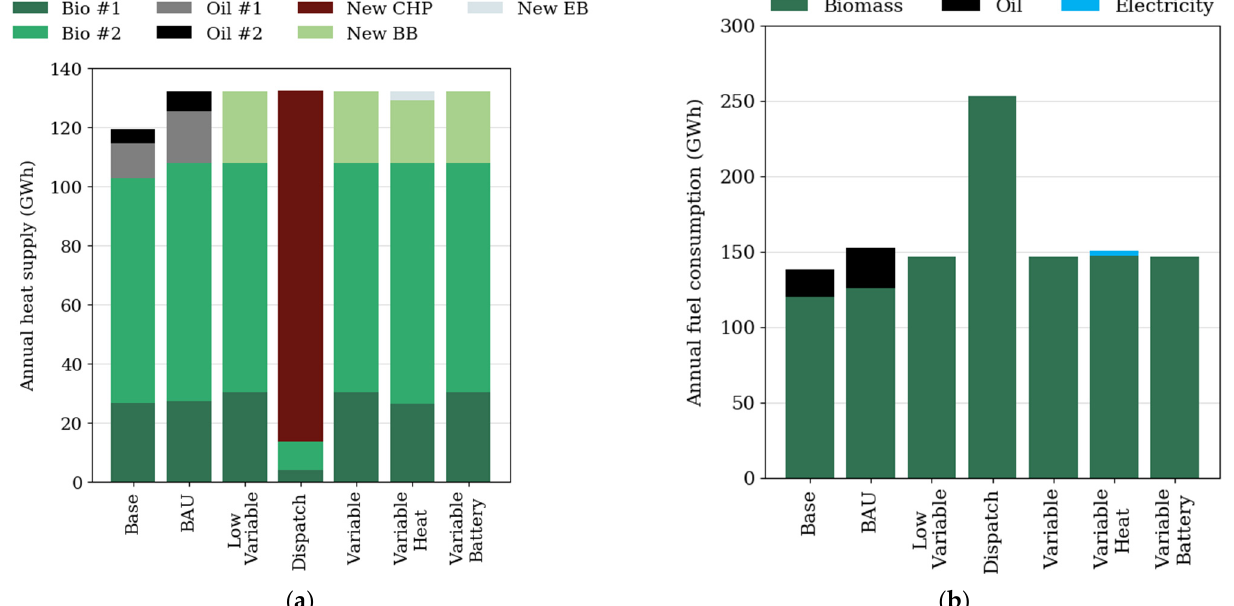
Figure 2. Simulated ( a ) district heat production and ( b ) fuel consumption of the different scenarios. In the former subfigure, New EB and New BB refer to new electric and biomass boiler capacity, respectively.